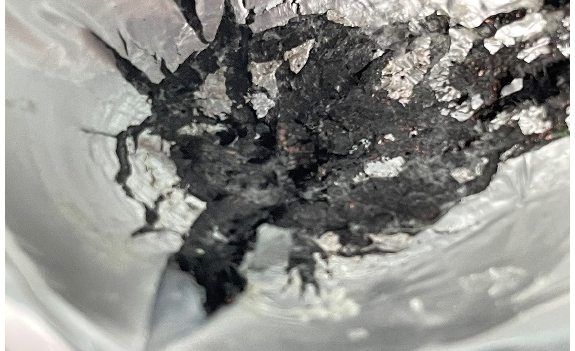
Figure 9. Internal details of the battery after the experiment.